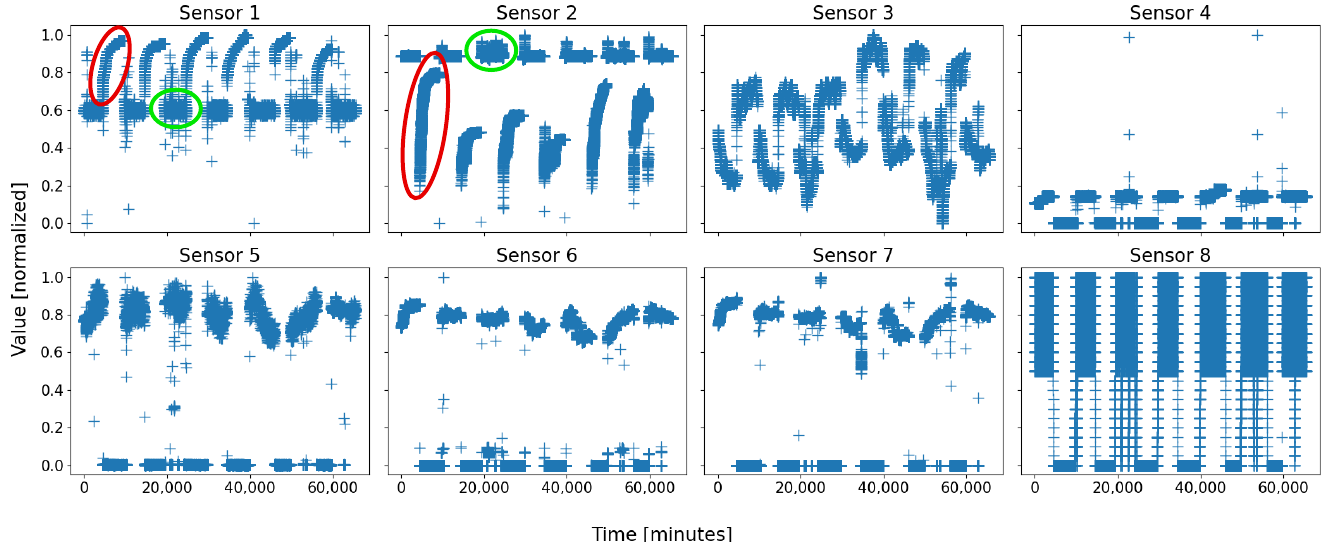
Figure 1. Battery 1 ( D 1 ) sensors over time. Two main motifs stand out, circled in red and green: the green coarsely corresponds to the steady state of the process, whereas the red is more the state of the sensors when the plant is shut down. A pair of red and green motifs forms a regular work week.